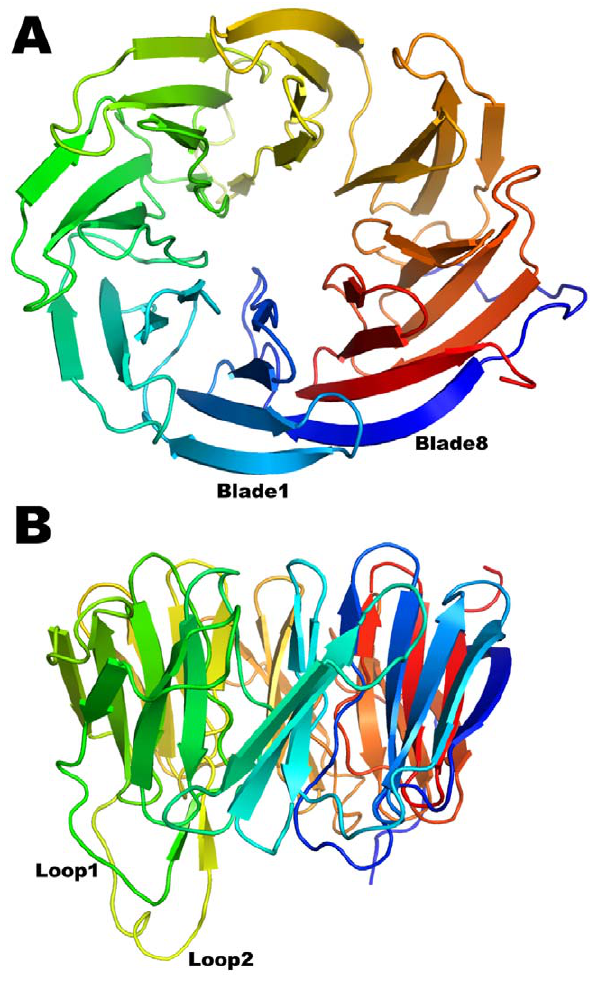
Figure 1. Structure of BamB. Top (A) and side (B) view of the eight bladed b -propeller fold of BamB color-ramped from blue (N-terminus) to red (C-terminus). The first and eighth blades are labeled for reference. Two protruding loops connecting blades 3 to 4 and 4 to 5 are labeled Loop 1 and 2 and colored green and yellow respectively.